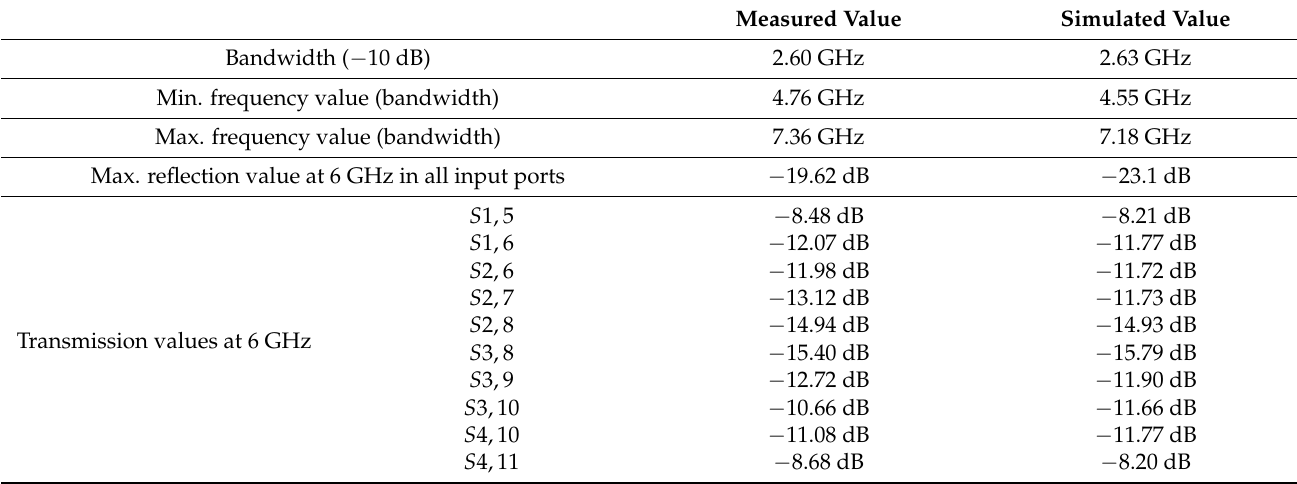
Table 3. Transmission and reflection values for the block of 4 × 7 CORPS